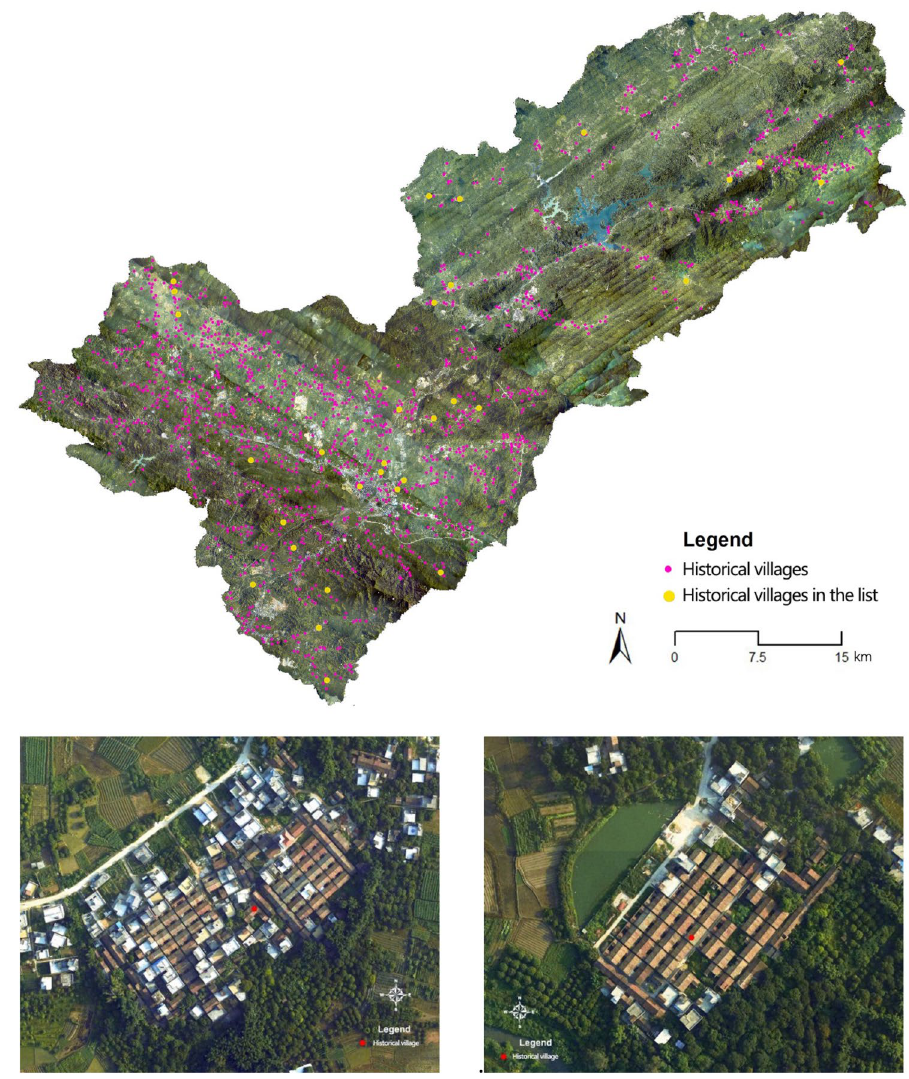
Fig. 16 The results of the iden- tification of traditional